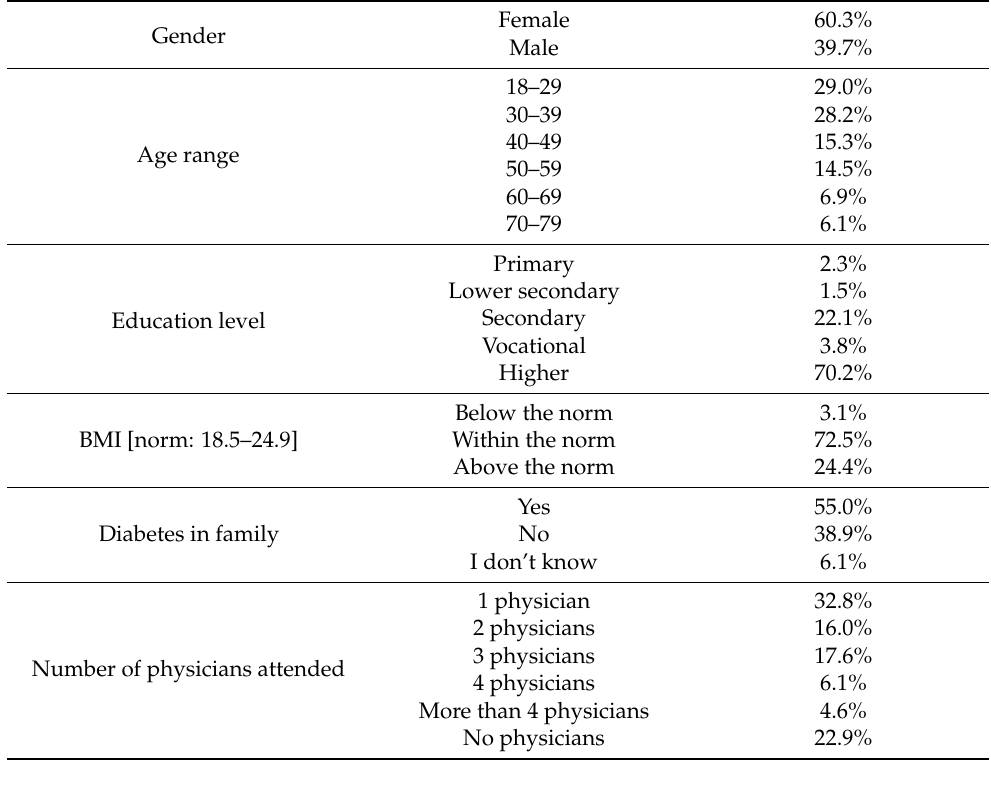
Table 1. Characteristics of the study group.